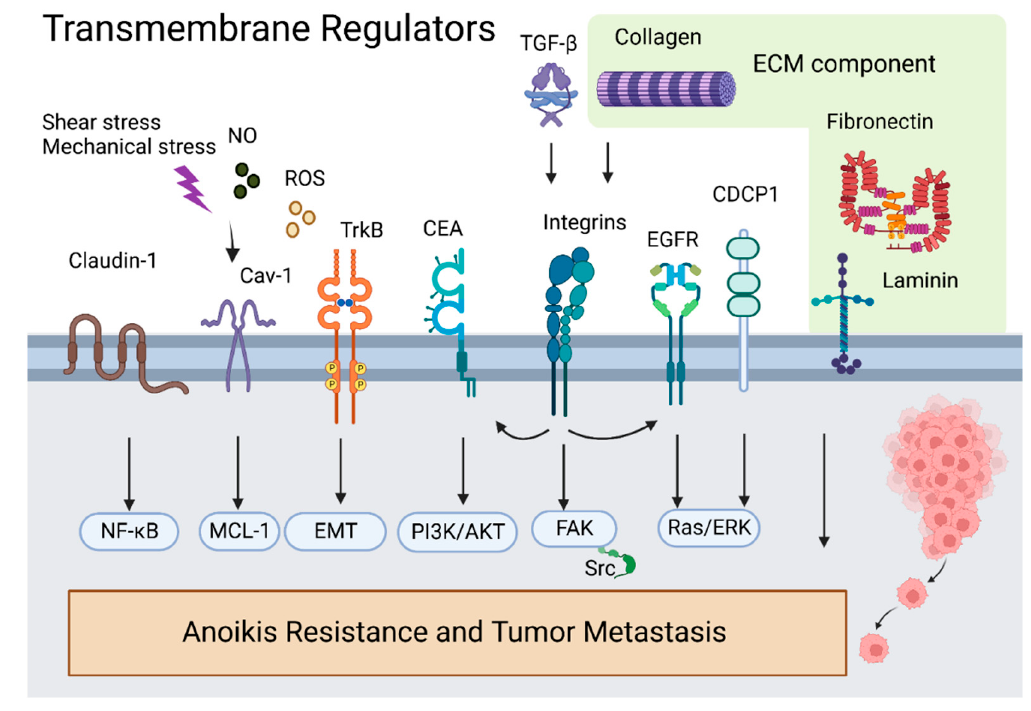
Figure 7. Overview of transmembrane regulators in anoikis-associated lung cancer metastasis.